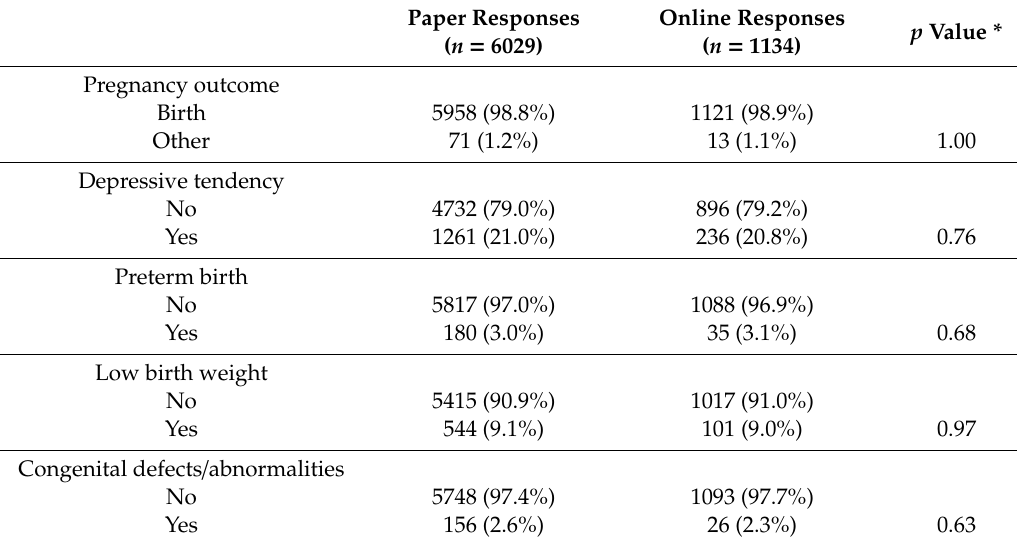
Table 2. Pregnancy outcomes: comparisons by survey method.